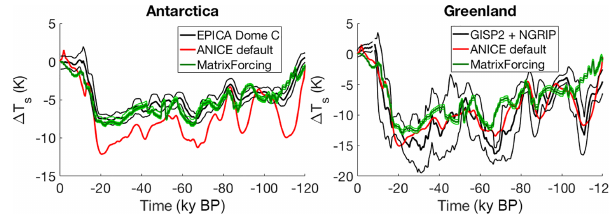
Figure 13. Modelled versus reconstructed temperature anomaly for Antarctica (EPICA Dome C; Jouzel et al., 2007) and Greenland (GISP2; Alley, 2000; NGRIP; Kindler et al.,